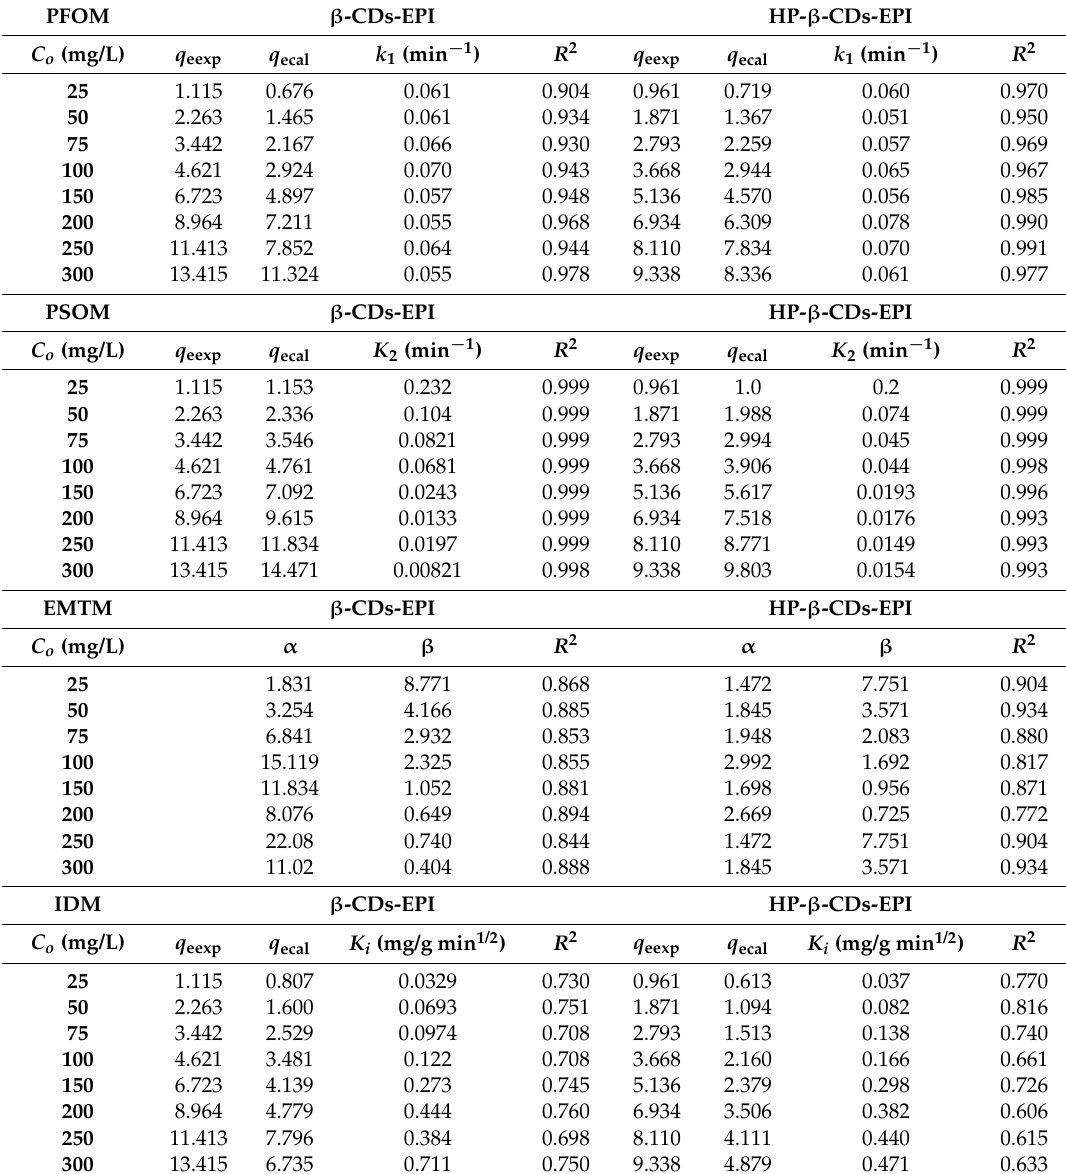
Table 2. Kinetics parameters for the Pseudo First and Second Order; Elovich Mass Transfer and Intraparticle Diffusion